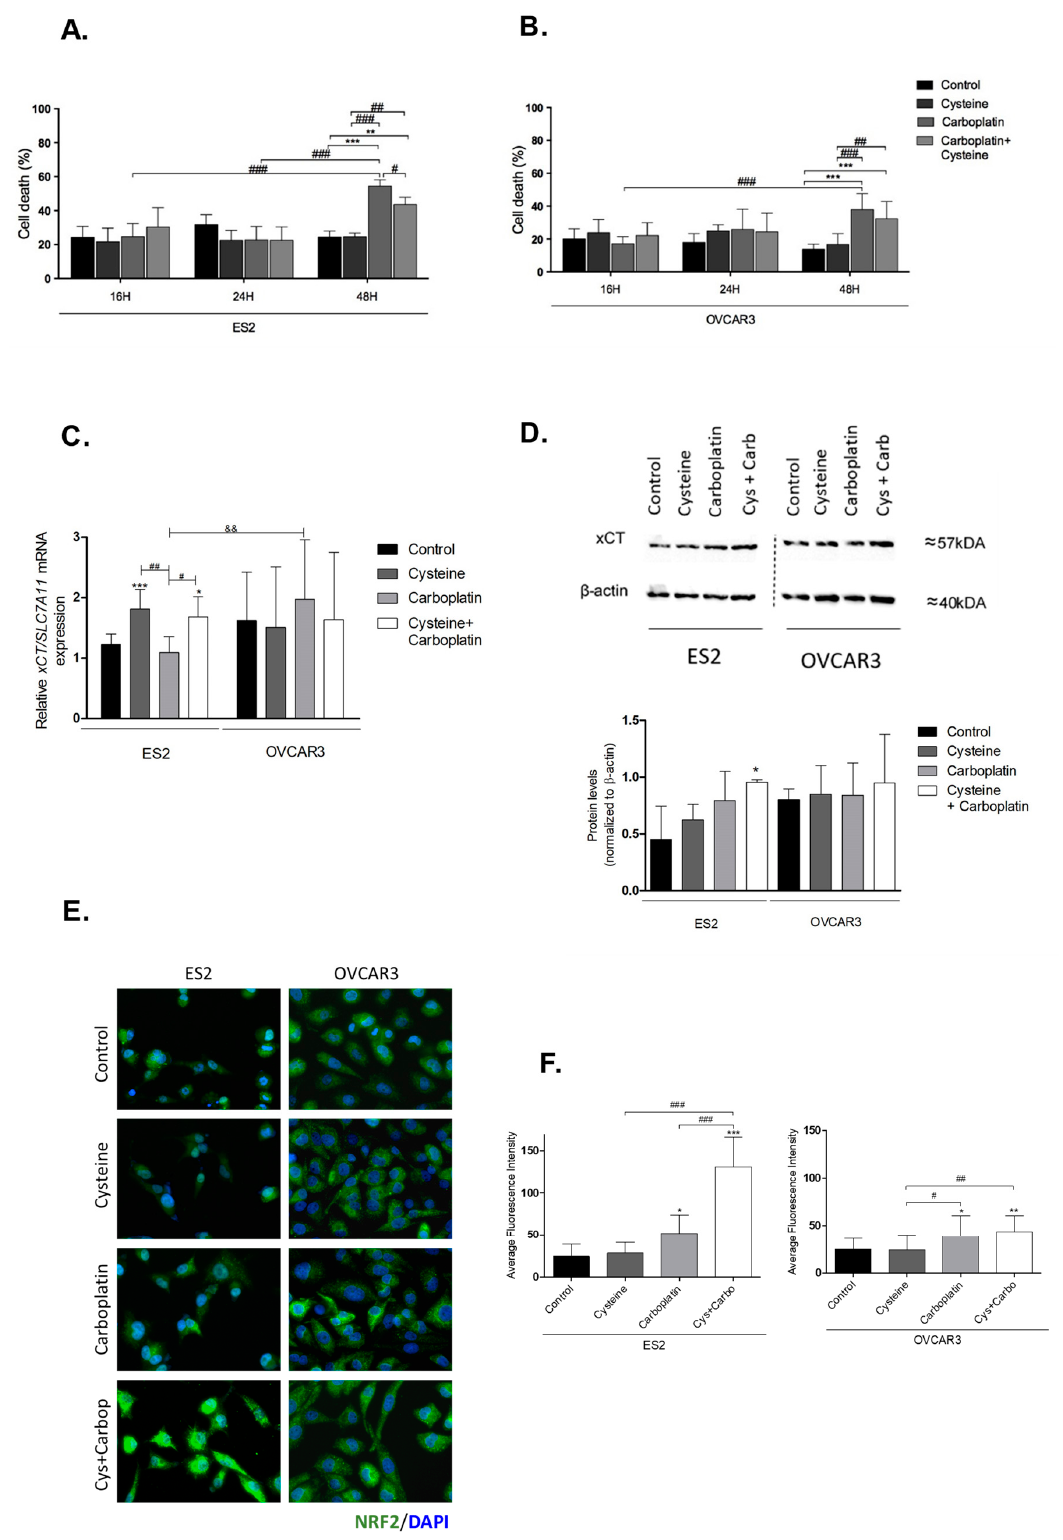
Figure 1. Putative involvement of cystine / glutamate antiporter system Xc (xCT) and nuclear factor erythroid 2-related factor 2 (Nrf2) in the protective effect of cysteine upon platinum salt exposure. ES2 and OVCAR3 cell lines were incubated with cysteine, carboplatin, and a combination of carboplatin with cysteine for 16 h ( A,B ). Cell death was determined by flow cytometry using annexin V fluorescein isothiocyanate (FITC) and propidium iodide (PI) staining. The xCT / soluble carrier protein